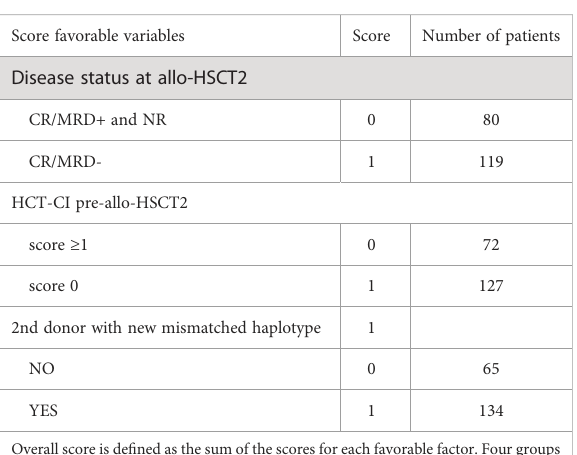
TABLE 5 Prognostic scoring system.